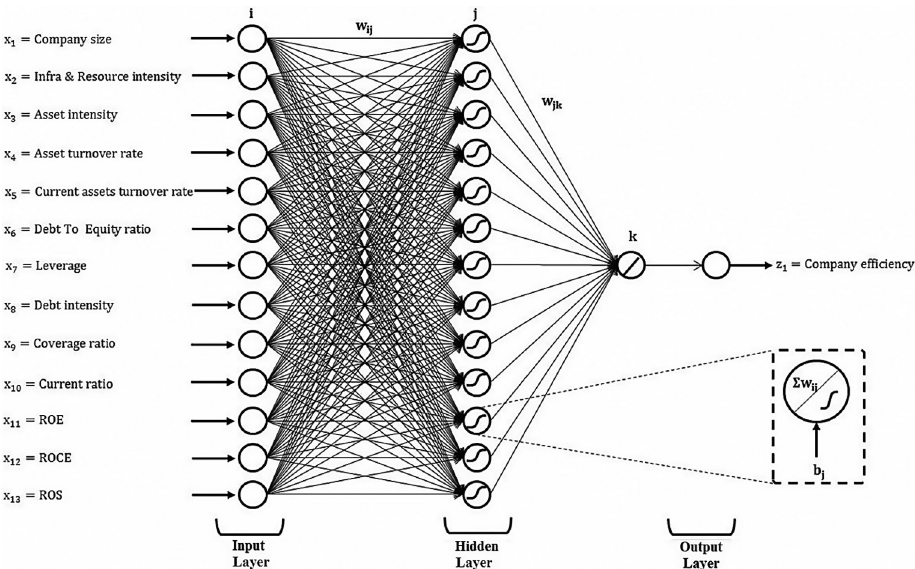
Fig. 2. Artificial neural network architecture Source : elaborated.